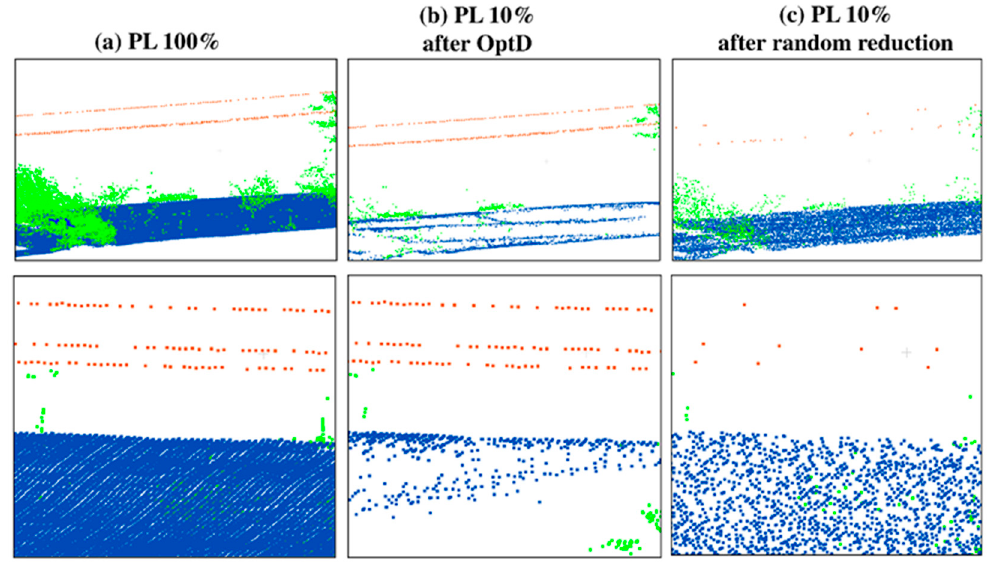
Figure 12. Fragments of the ALS dataset including power lines: ( a ) original, ( b ) PL after OptD method, ( c ) PL after random reduction.